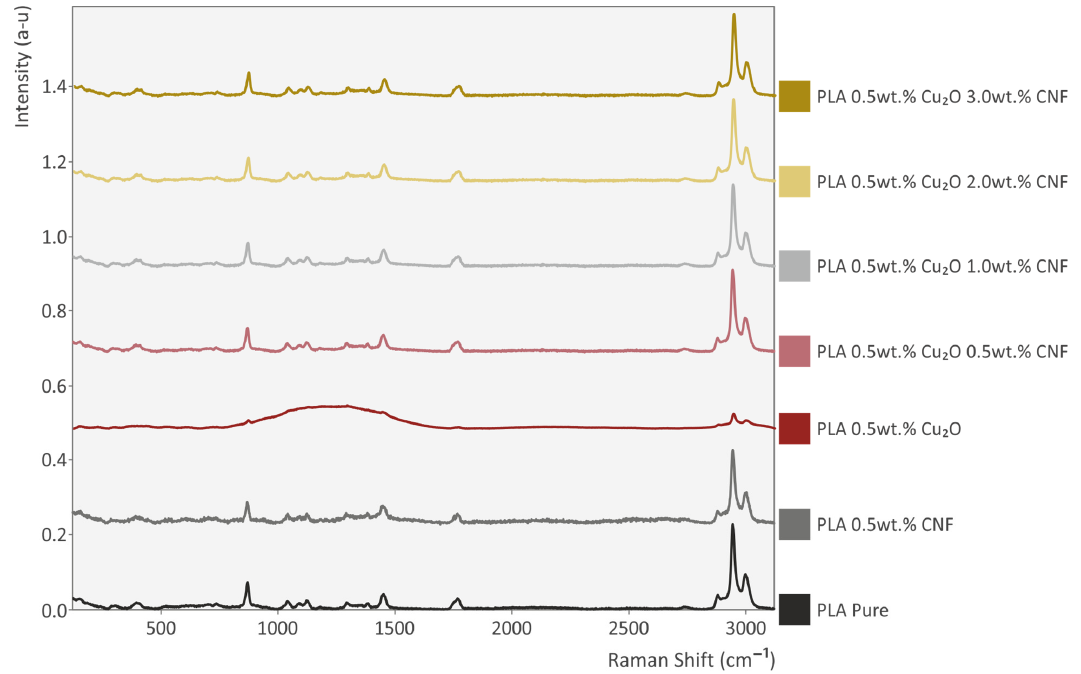
Figure 6. Raman spectra graphs depicting the characteristic peaks for all tested materials. The major Raman peaks identified in analysis of pure PLA, as well as their related assignments, are presented in Table 1. The range of the identified Raman peaks is between 870 cm − 1 and 1996 cm − 1 . Table 1. Major identified Raman peaks and their related assignments.